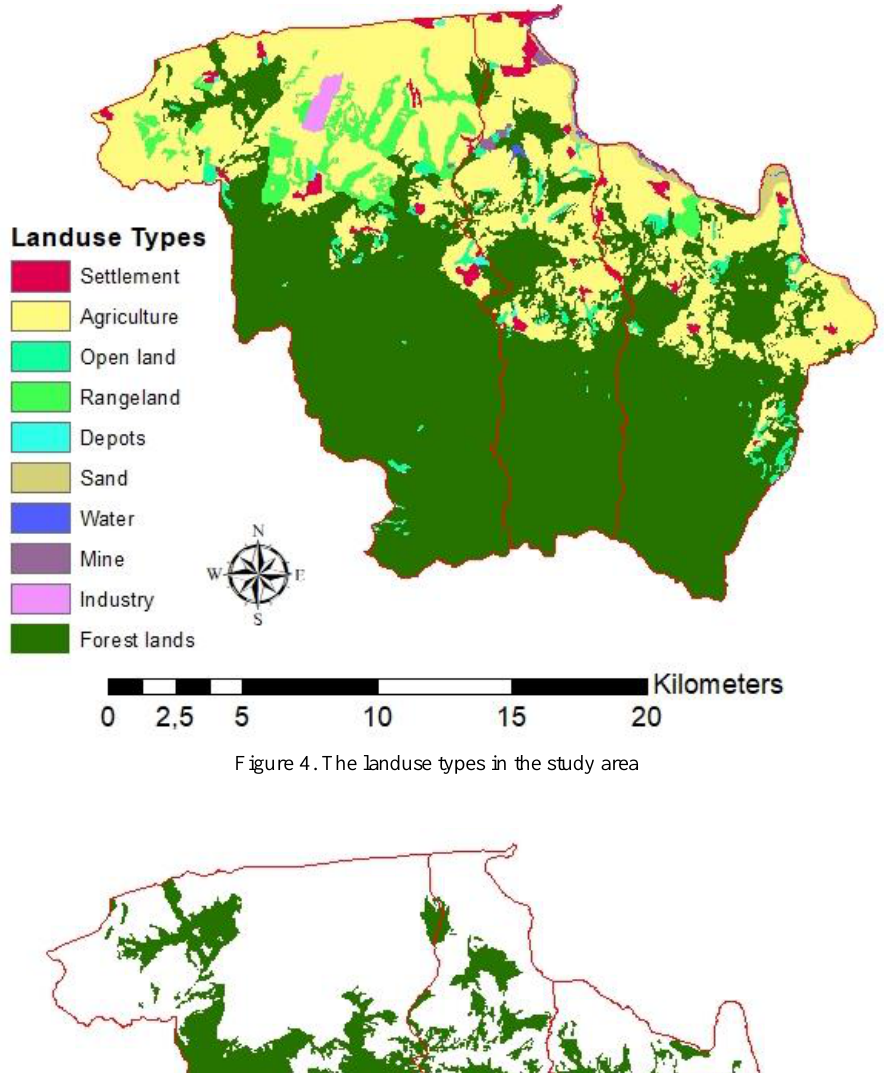
Figure 4. The landuse types in the study area